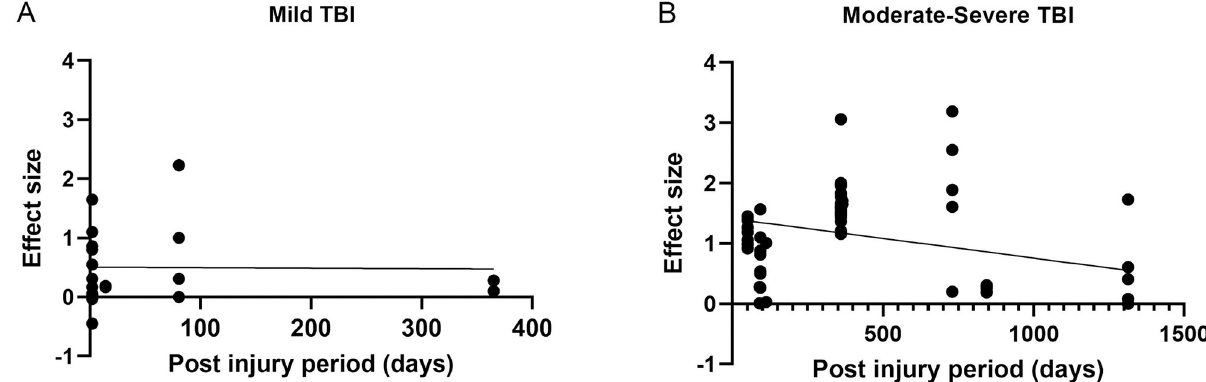
Fig 6. Meta-regression analyses between effect sizes and post injury period in the two main severity subgroups. Fig 6A shows effect size estimates for studies of mild TBI and Fig 6B shows that of moderate-to-severe TBI. Each figure includes the line of best fit for each group.